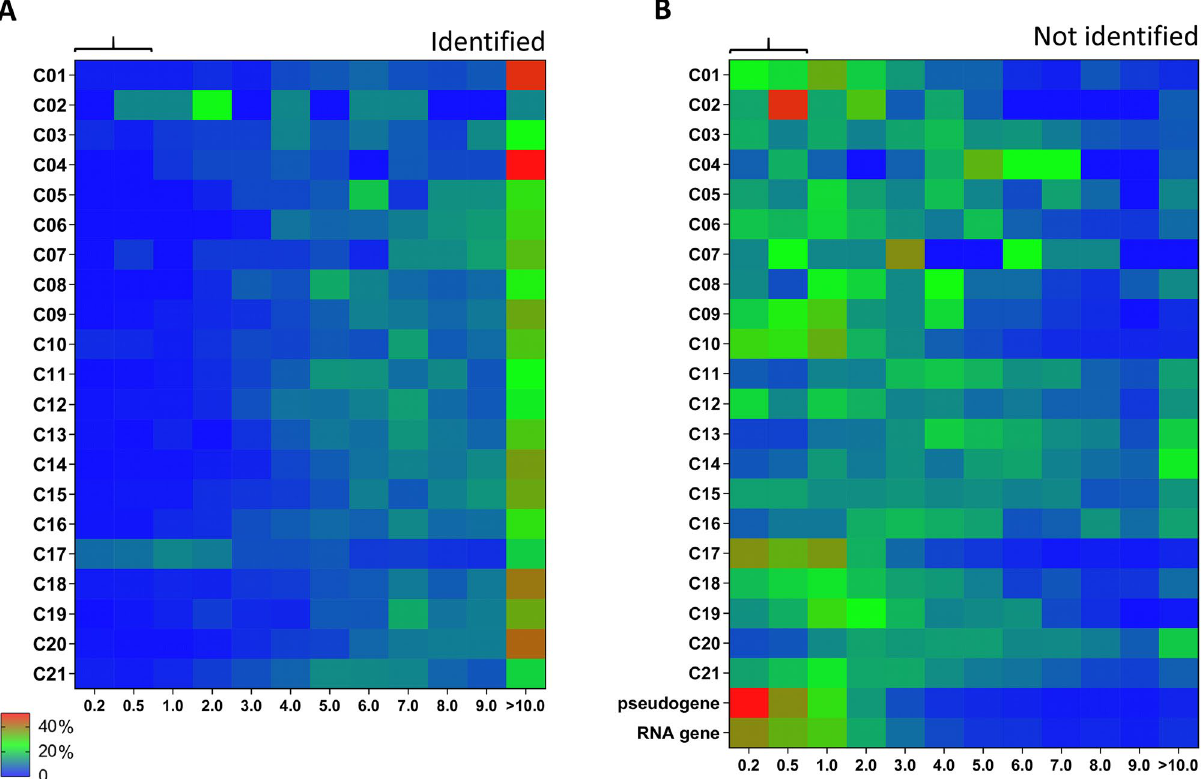
Figure 6. Distribution profile of relevant transcripts of per protein function class. For the relevant platelet transcriptome ( n = 17,629), heatmaps were constructed of percentual distribution of transcript levels per function class (rainbow colors; blue = low, red = high). ( A ) Heatmap for transcripts of identified proteins ( n = 5,030). ( B ) Heatmap for transcripts of non-identified proteins ( n = 9,267); furthermore RNA genes ( n = 2,480) and pseudogenes ( n = 852). Expression levels (log2fpkm) were binned as 0.20–0.50, 0.50–1.00, 1.00–2.00, etc. For numbers of transcripts, see Suppl. Figure